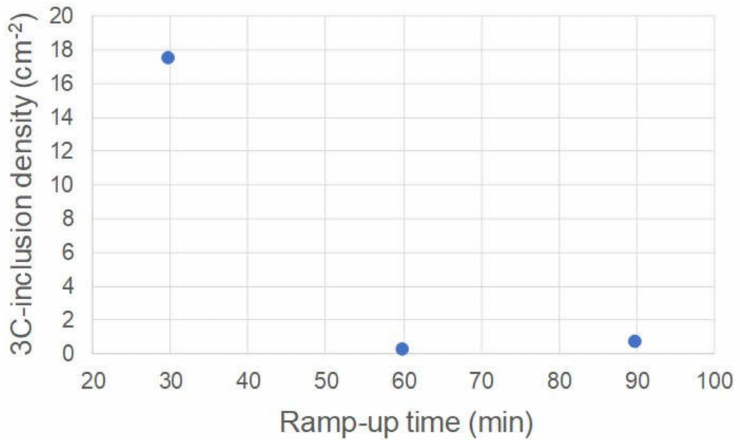
Figure 7. Dependence of the 3C-inclusion density of the on-axis 4H-SiC epitaxial layers at the growth rate of 40 µ m / h on the ramp-up time.